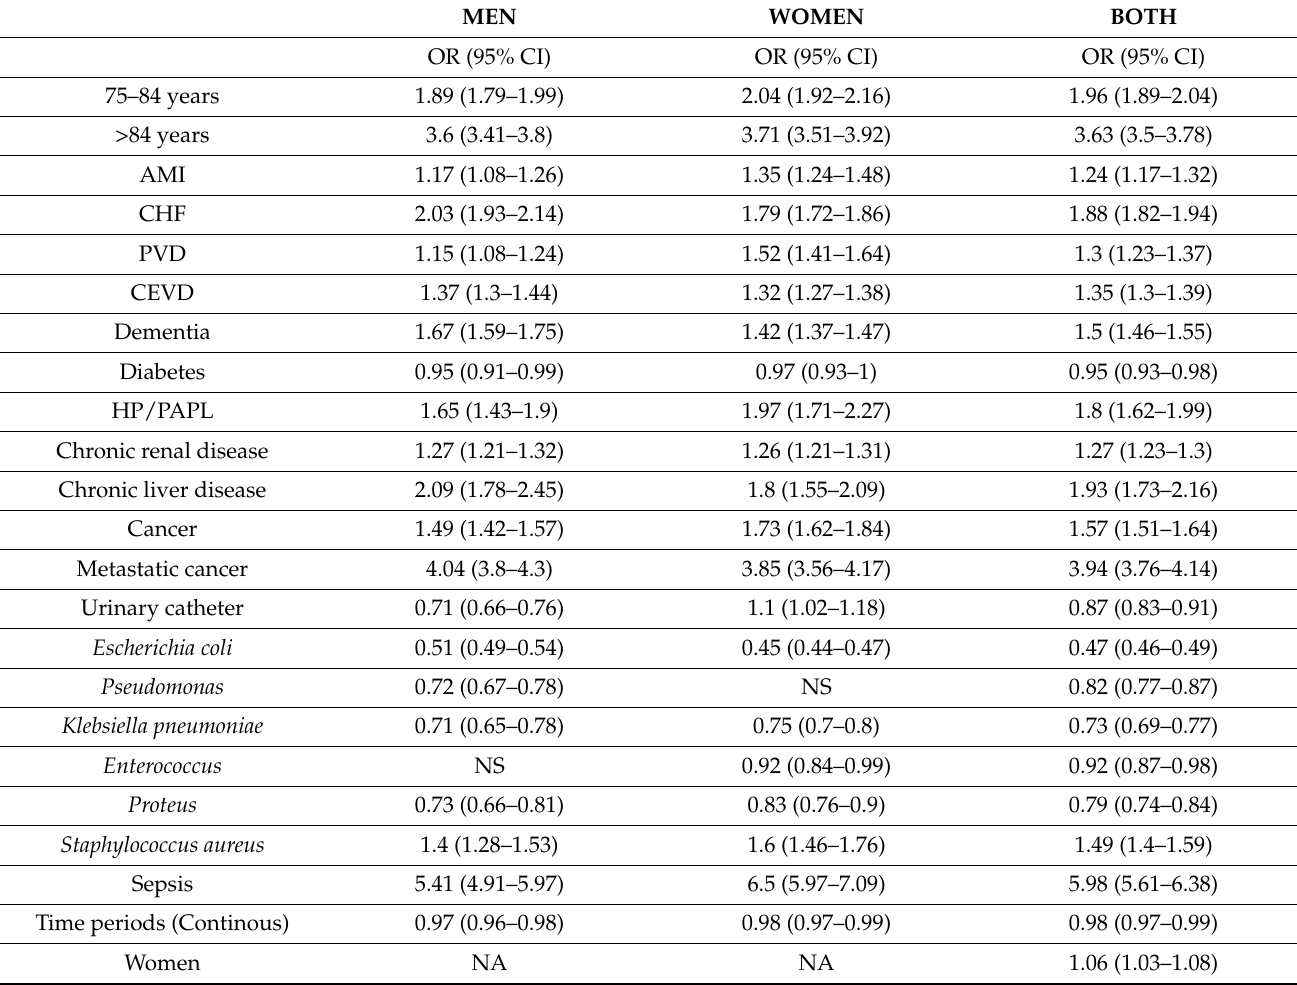
Table 6. Variables associated with in-hospital mortality in hospital admissions of elderly patients with a principal diagnosis of urinary tract infection according to sex in Spain